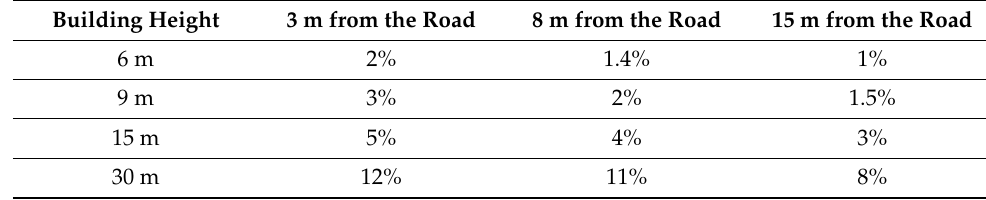
Table 7. Percentage deviation from shaded